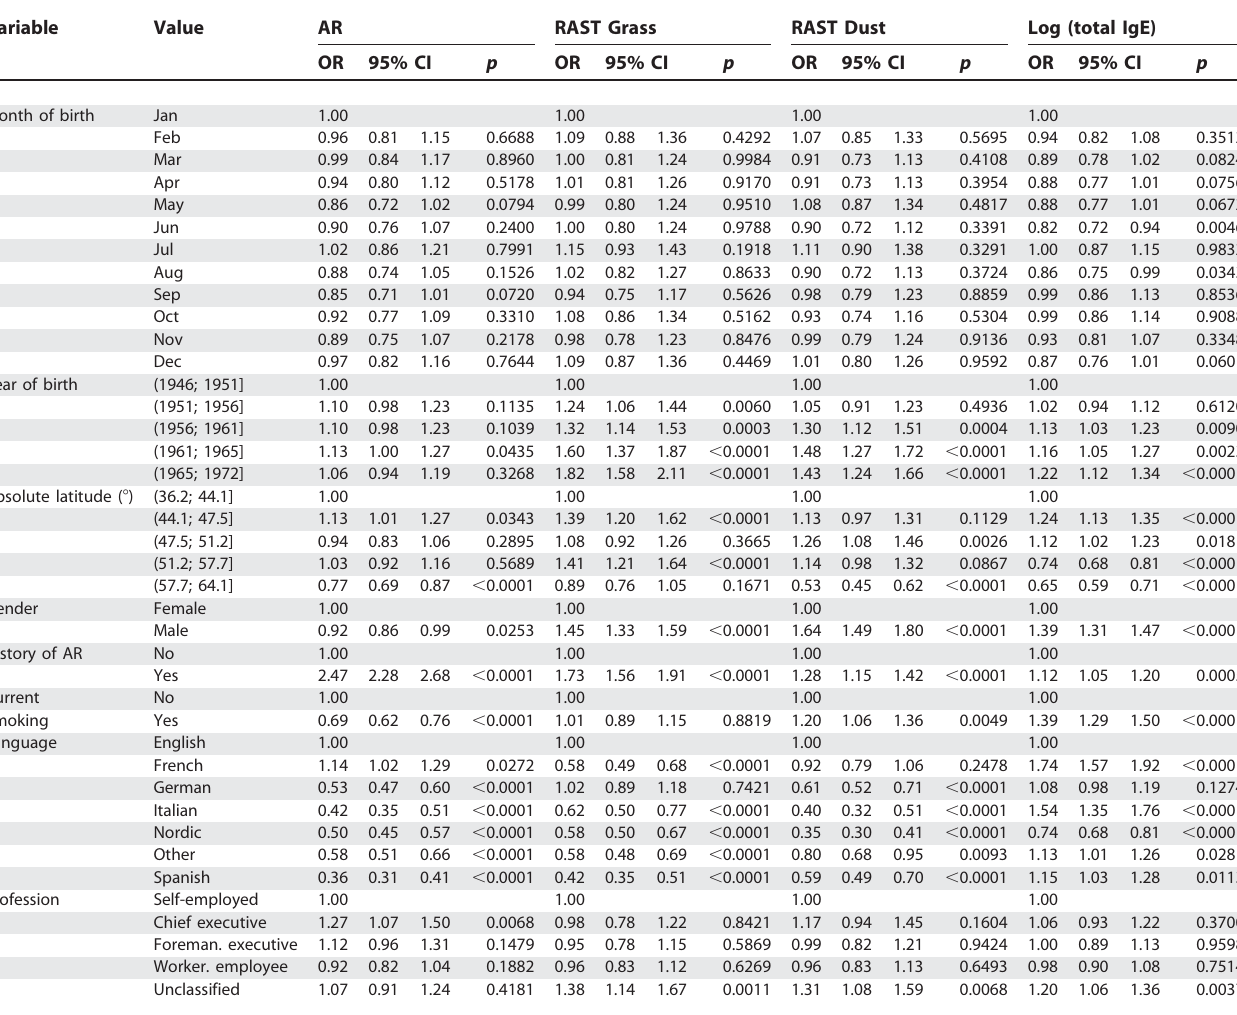
Table 2. Crude Risk for AR, Total IgE, and Sensitization against Grass or House Dust Mite in ECRHS I Main Study